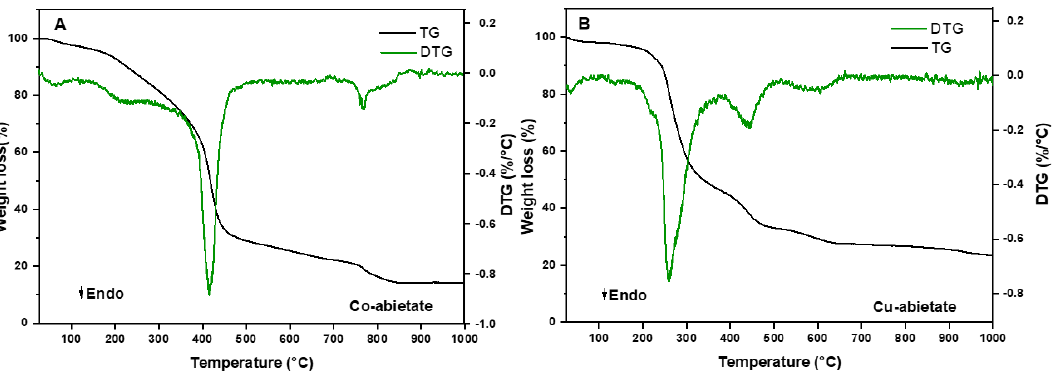
Figure 8. Thermal Decomposition of ( A ) Co-abietate, and ( B ) Cu-abietate samples by TG/DTG.